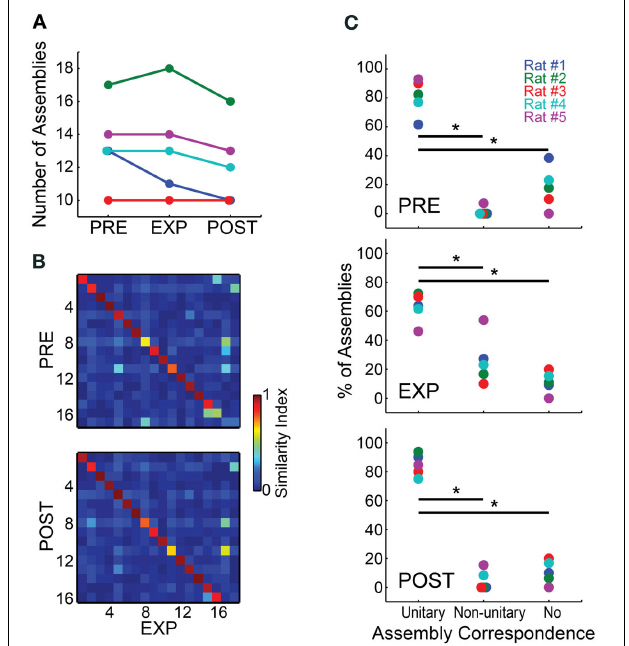
FIGURE 3 | Cell assemblies are highly conserved across experimental periods. (A) Number of assemblies detected using spike matrices from the different experimental periods. (B) SI values among assembly patterns of rat #2 across experimental periods. Assembly patterns were detected using a 5ms bin size. Assembly labels were sorted to let highest values in the main diagonal. (C) For each experimental period, the panels show the percentages of assemblies within each of the categories defined by the number of significant correspondences between the assemblies of a given experimental period and the assemblies from flanking periods (from top to bottom, PRE, EXP and POST). Two assembly patterns were deemed correspondent if their SI was above a threshold set by a bootstrap procedure ( p = 0 . 0001). The categories were defined as unitary correspondence, non-unitary correspondence and no correspondence, representing the percentage of assemblies within rats that showed, respectively, a single correspondence between flanking periods, two or more flanking correspondences, or no correspondence whatsoever. Note that the percentage of assemblies within the unitary correspondence category was considered significantly higher than the other categories for all experimental periods (Wilcoxon ranksum test, ∗ p < 0 . 05, Bonferroni